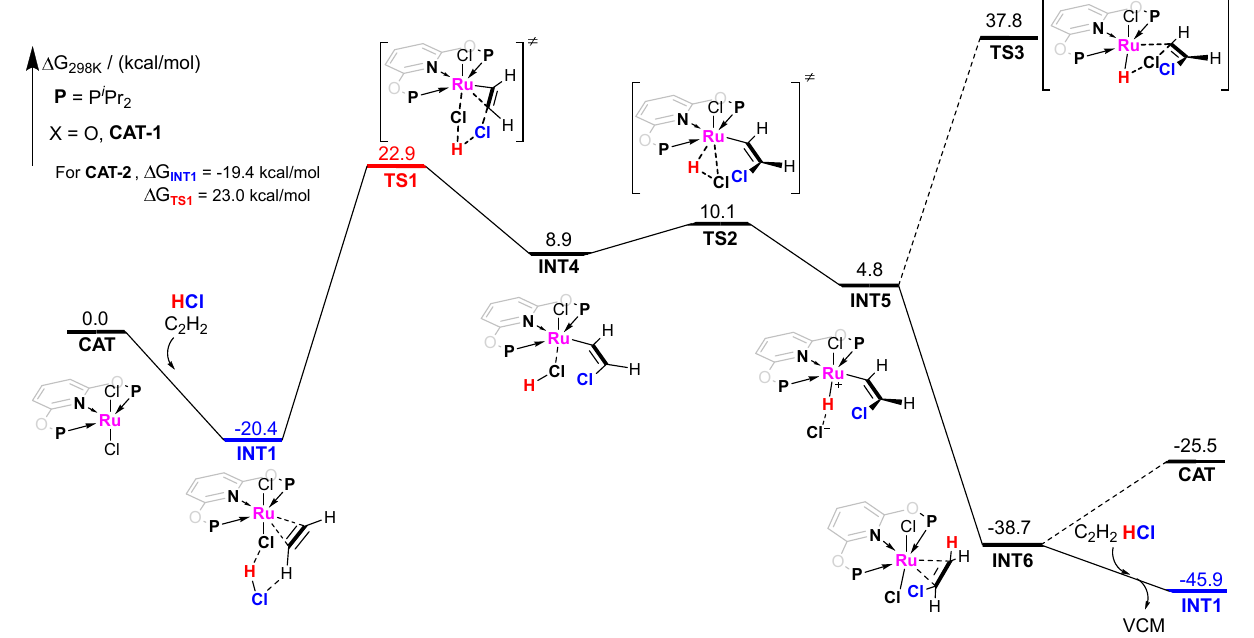
Figure 4. Gibbs free energy profile for molecular complex CAT − 1 catalyzed acetylene hydrochlorination mechanism pathway − 1.